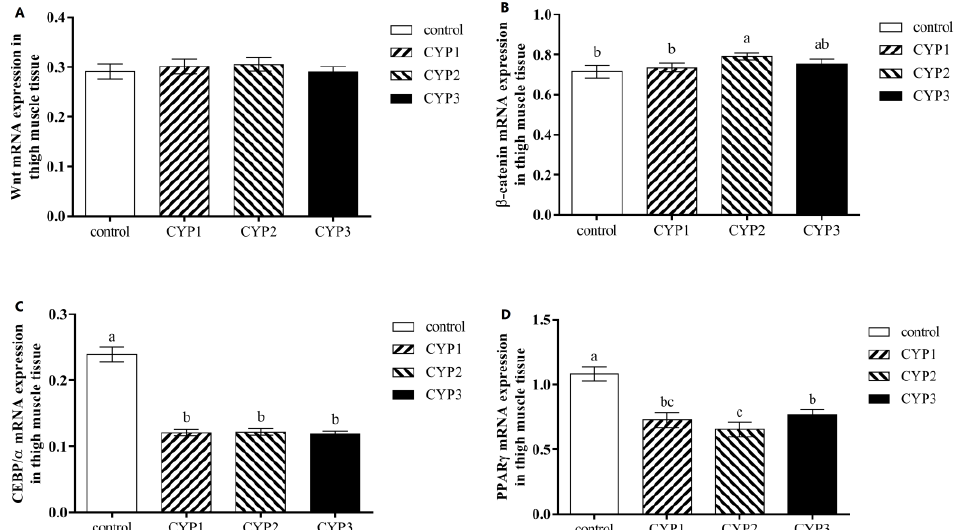
Figure 1. The Wnt1 ( A ), β -catenin ( B ), CEBP α ( C ), and PPAR γ ( D ) mRNA expressions in thigh muscle of broilers. a,b,c The difference between the small letters indicates a significant difference ( p < 0.05). Control, basic diet; CYP1, CYP2, and CYP3 represent the basal diet supplemented with 250, 500, and 1000 CYP, respectively. PPAR γ , peroxisome proliferation-activated receptor γ ; C/EBP α , CCAAT/enhancer binding protein α.